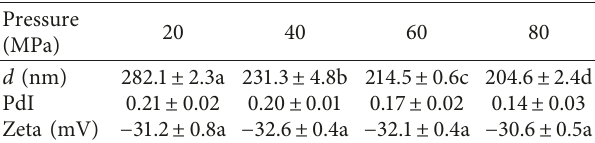
Table 1: Droplet characteristics of the sea buckthorn oil-in-water emulsions (oil: 5g/100g; SC: 1g/100g) produced at different ho- mogenization